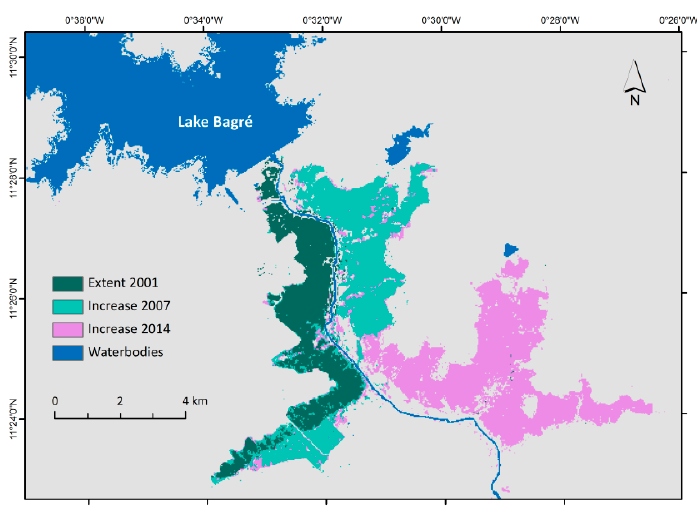
Figure 7. Development of an irrigation area at the Bagré dam in southern Burkina Faso between 2001 and 2014; Location of focus area within Burkina Faso is marked in Figure 6.